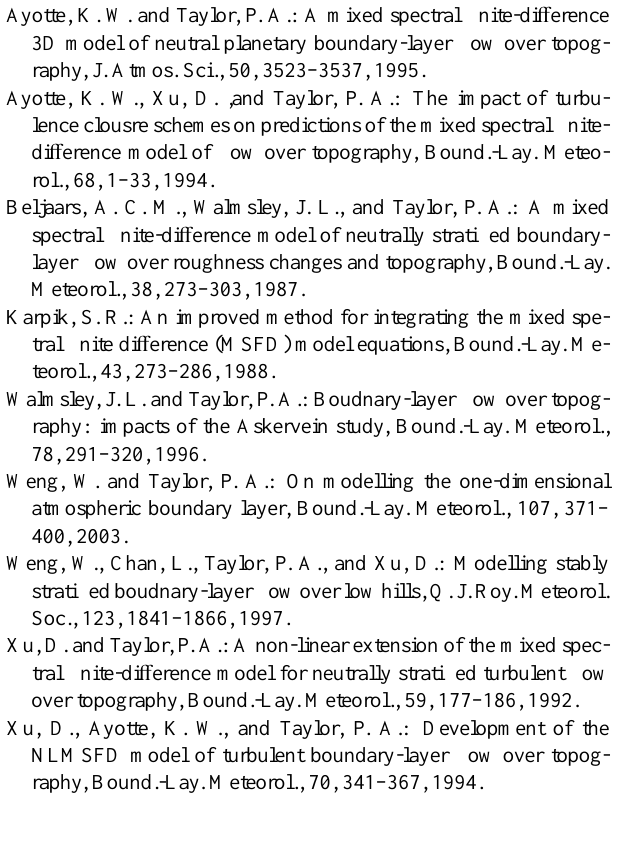
Figure 4. Fractional speed-up ratio, ∆ S , for flow over Askervein hill at a height of 10 m above topography along line AA. Comparison of model results and experimental data.